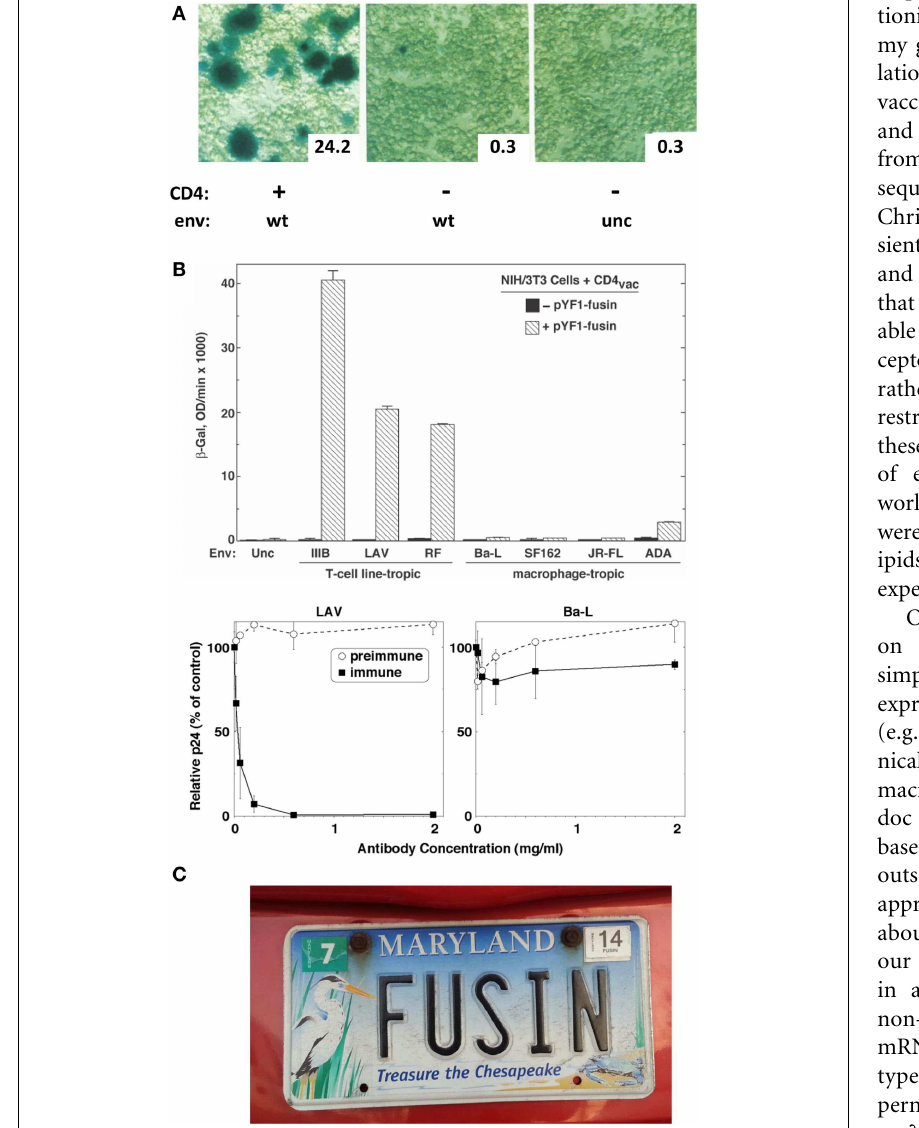
FIGURE 1 | (A) Reporter gene assay for HIV-1 Env/CD4-mediated cell fusion. Effector HeLa cells expressed vaccinia-encoded HIV Env wild type (WT) or a non-functional uncleaved mutant (unc) and were transfected with a plasmid containing the LacZ gene linked to theT7 promoter.Target HeLa cells expressed vaccinia-encodedT7 RNA polymerase with ( + ) or without ( − ) CD4. Duplicate cell mixtures were incubated at 37°C for 2.5h and β -galactosidase was measured in one set by in situ staining (photomicrographs) and in the other by colorimetric assay of detergent cell lysates (insets, arbitrary units). Adapted from Ref. (8). (B) Demonstration of fusin’s function as an entry receptor forTCL-tropic HIV-1. Top panel . Cell fusion assay. Effector NIH 3T3 cells expressed vaccinia-encoded Env from the indicatedTCL-tropic or M-tropic HIV-1 isolate as well asT7 RNA polymerase.Target NIH 3T3 cells were co-transfected with the plasmid containing the LacZ gene linked to theT7 promoter plus either a control plasmid (filled bars) or a plasmid encoding fusin (cross-hatched bars). Cell mixtures were incubated at 37°C for 3hr, and β -galactosidase was measured by the colorimetric assay of detergent cell lysates. Bottom panel . HIV-1 infection assay. PBMCs were pre-incubated with the indicated concentrations of purified rabbit antibodies [preimmune, and immune against the fusin N-terminus], then infected with HIV-1 LAV (left,TCL-tropic) or Ba-L (right, M-tropic). Culture supernatants were assayed by ELISA for p24 content at day 7. Results for each isolate are expressed as the percentage of p24 produced at each antibody concentration compared to the control value with no antibody. From Ref. (9). (C) . Rare detection of the name “fusin.” From the Maryland Department of